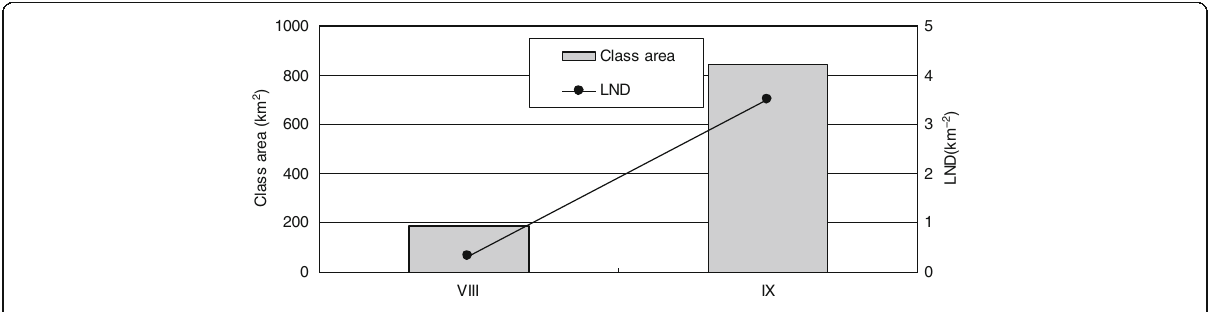
Fig. 14 Same as Fig. 10 but for seismic intensity ( horizontal